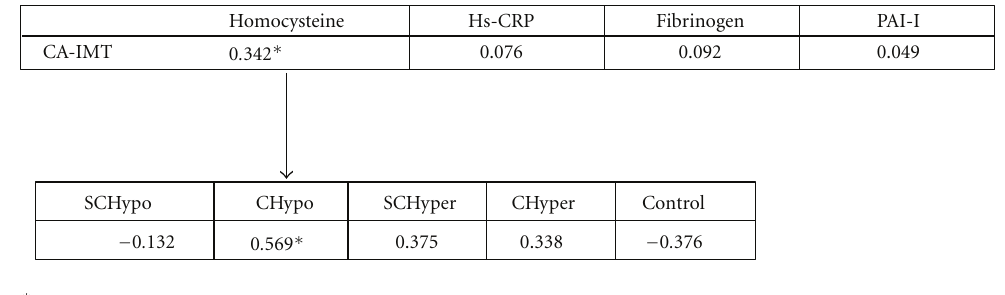
Figure 1: Correlations between homocysteine, hs-CRP, fibrinogen, PAI-1, and CA-IMT and correlations of homocysteine and CA-IMT between thyroidism groups. PAI-I: plasminogen activator inhibitor-1; CA-IMT: carotid intima media thickness; SCHypo: subclinical hypothyroidism; CHypo: clinical hypothyrodism; SCHypo: subcilinical hyperthyroidism; CHyper: clinical hyperthyroidism.